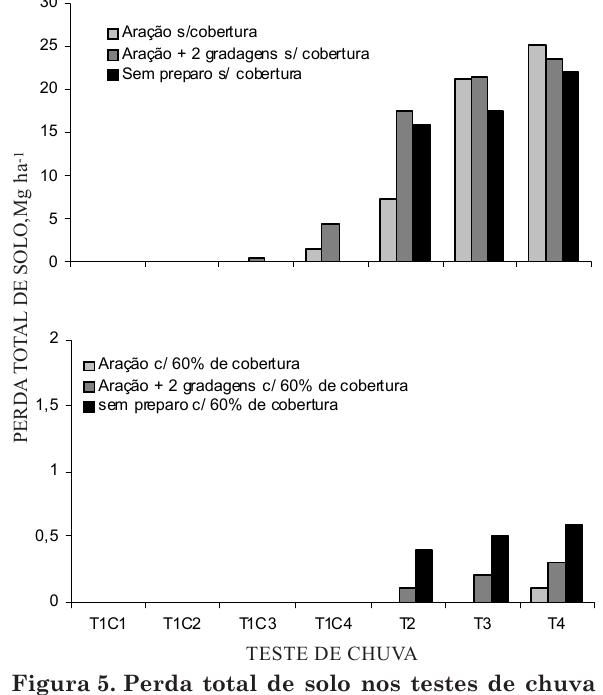
Figura 5. Perda total de solo nos testes de chuva simulada realizados nos tratamentos estudados (T1, T2, T3 e T4 = testes de chuva 1, 2, 3 e 4, aplicados logo, 1, 20 e 35 dias após o preparo do solo, respectivamente; C1, C2, C3 e C4 = segmentos de chuva 1, 2, 3 e 4 de T1, com durações de 20, 20, 30 e 30 min, respectivamente; as chuvas dos Testes 2, 3 e 4 foram contínuas e tiveram 90 min de duração. Obs: não foi realizado o Teste 1 no tratamento sem preparo do solo, tanto na ausência quanto na presença de